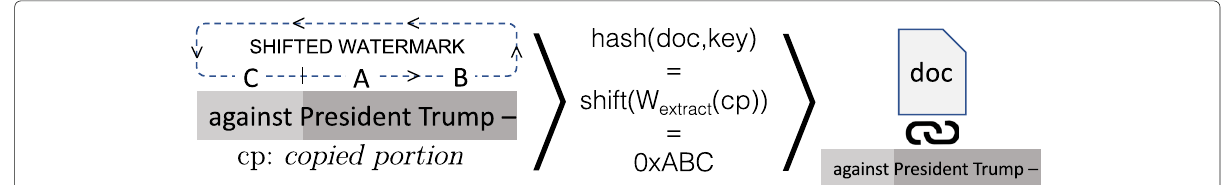
Fig. 5 Continuous part-of-whole watermarking. Any sufficiently long excerpt of text will keep the watermark when copied, independently from its position in the document. Because its watermark is derived from the whole origin document, any watermarked excerpt of sufficient length is bind to its